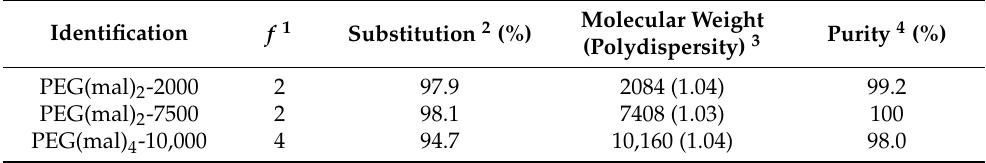
Table 1. Identification and characteristics of the poly(ethylene)glycol -maleimide derivatives.